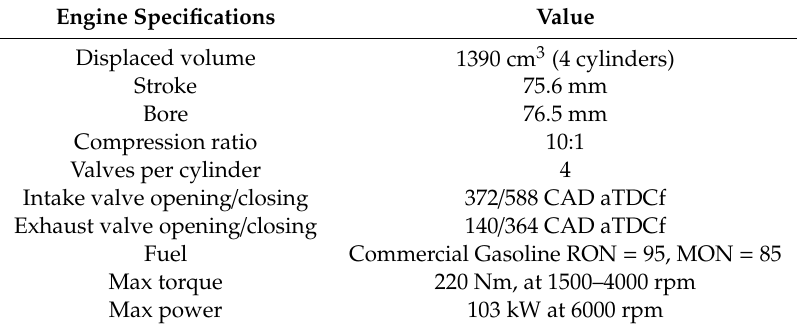
Table 1. Engine specifications.